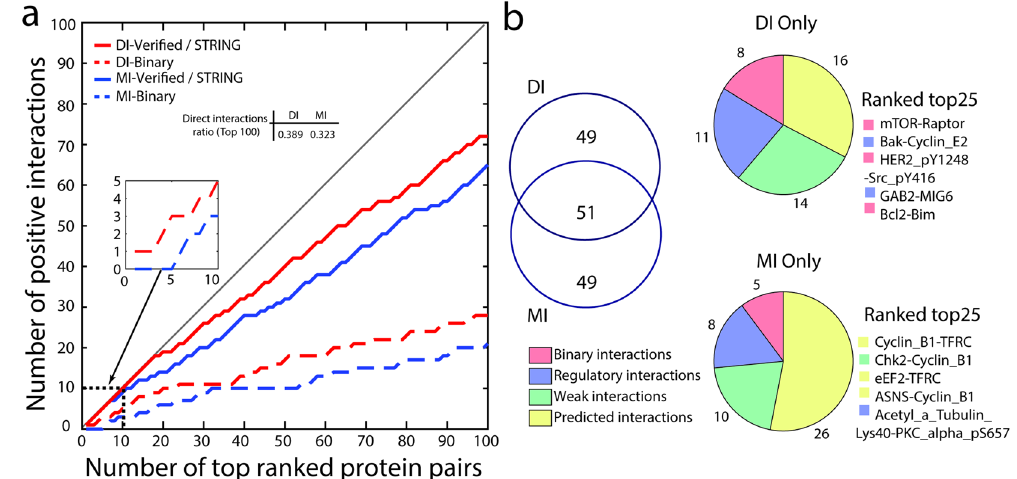
Figure 2. Protein-protein interaction pairs predicted from pan cancer protein expression levels with DCA. ( a ) Positive prediction values comparison between the direct information and mutual information. Solid line plots indicate number of protein-protein pairs verified with a curated literature review and STRING pairs with a combined scored at medium confidence (y-axis) against total number of pairs (x-axis) ranked by DI values (red) or MI (blue) values. Dash line plots indicate coupling pairs identified as binary interactions classified from a literature review and STRING pairs with experimental scores at highest confidence. The ratios of direct interactions to the all verified interactions for top 100 pairs are shown in the inset table. ( b ) Comparison of top 100 DI ranked and MI ranked predicted pairs. The pie charts on the right panel represent the distinct protein pairs in both groups with different colors indicating different categories. The digits near the pie charts are the number of protein pairs included into according category. Two lists named Ranked Top 25 show the detailed protein pairs that appear distinctly in the top 25 pairs by DI and MI methods.